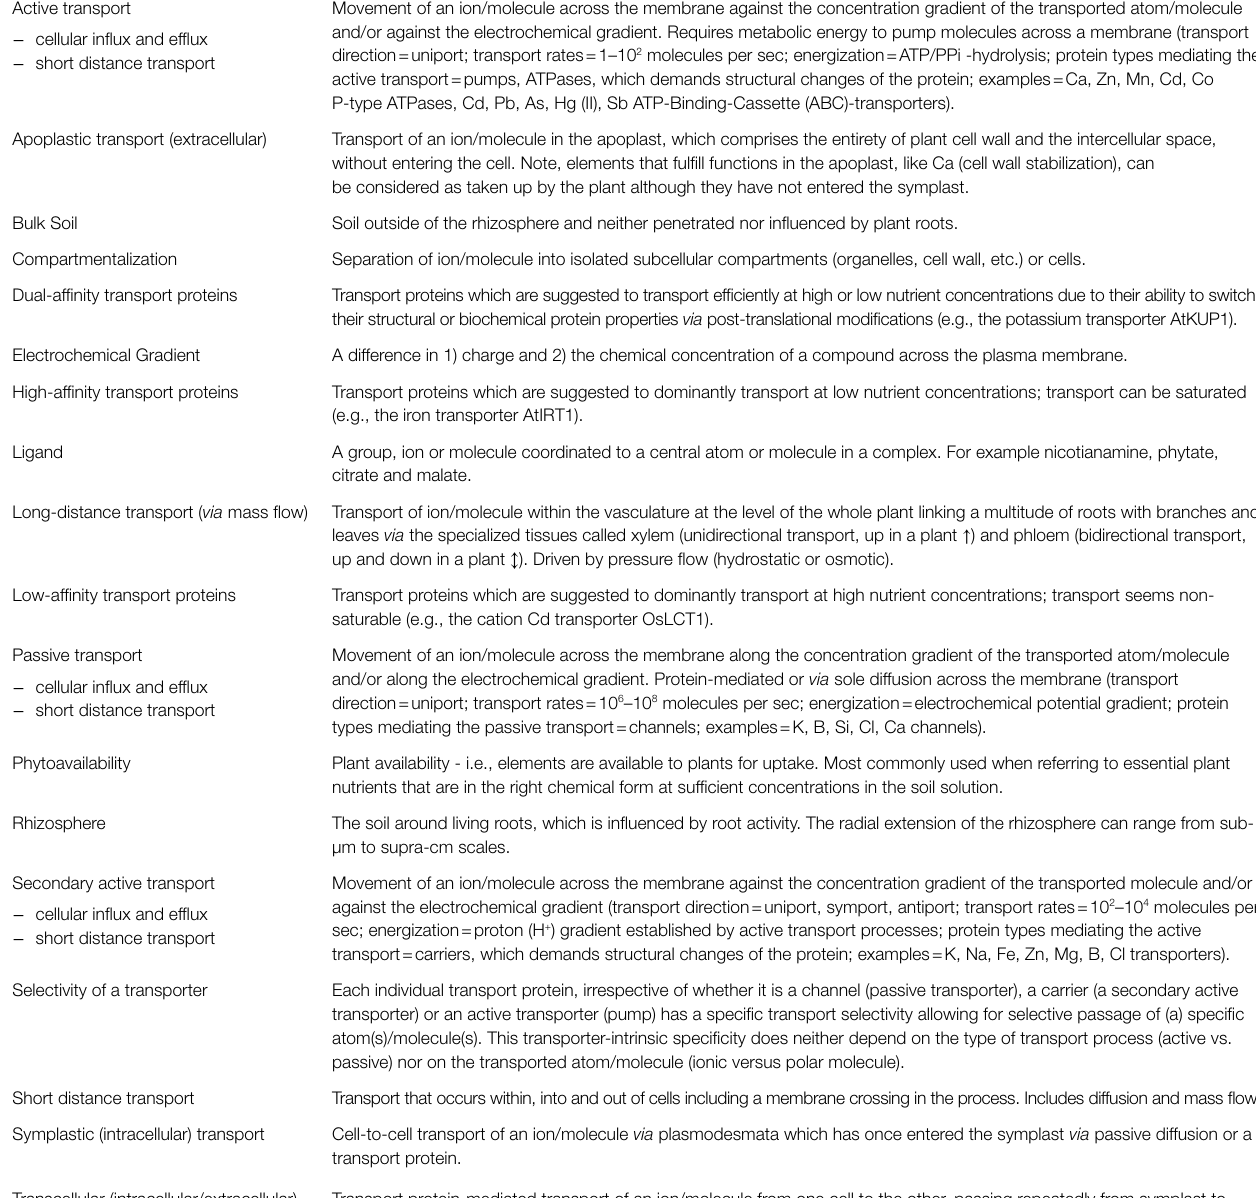
TABLE 3 | Glossary of terms and processes relevant for understanding isotope fractionation in plants (in alphabetical order). Active transport Movement of an ion/molecule across the membrane against the concentration gradient of the transported atom/molecule and/or against the electrochemical gradient. Requires metabolic energy to pump molecules across a membrane